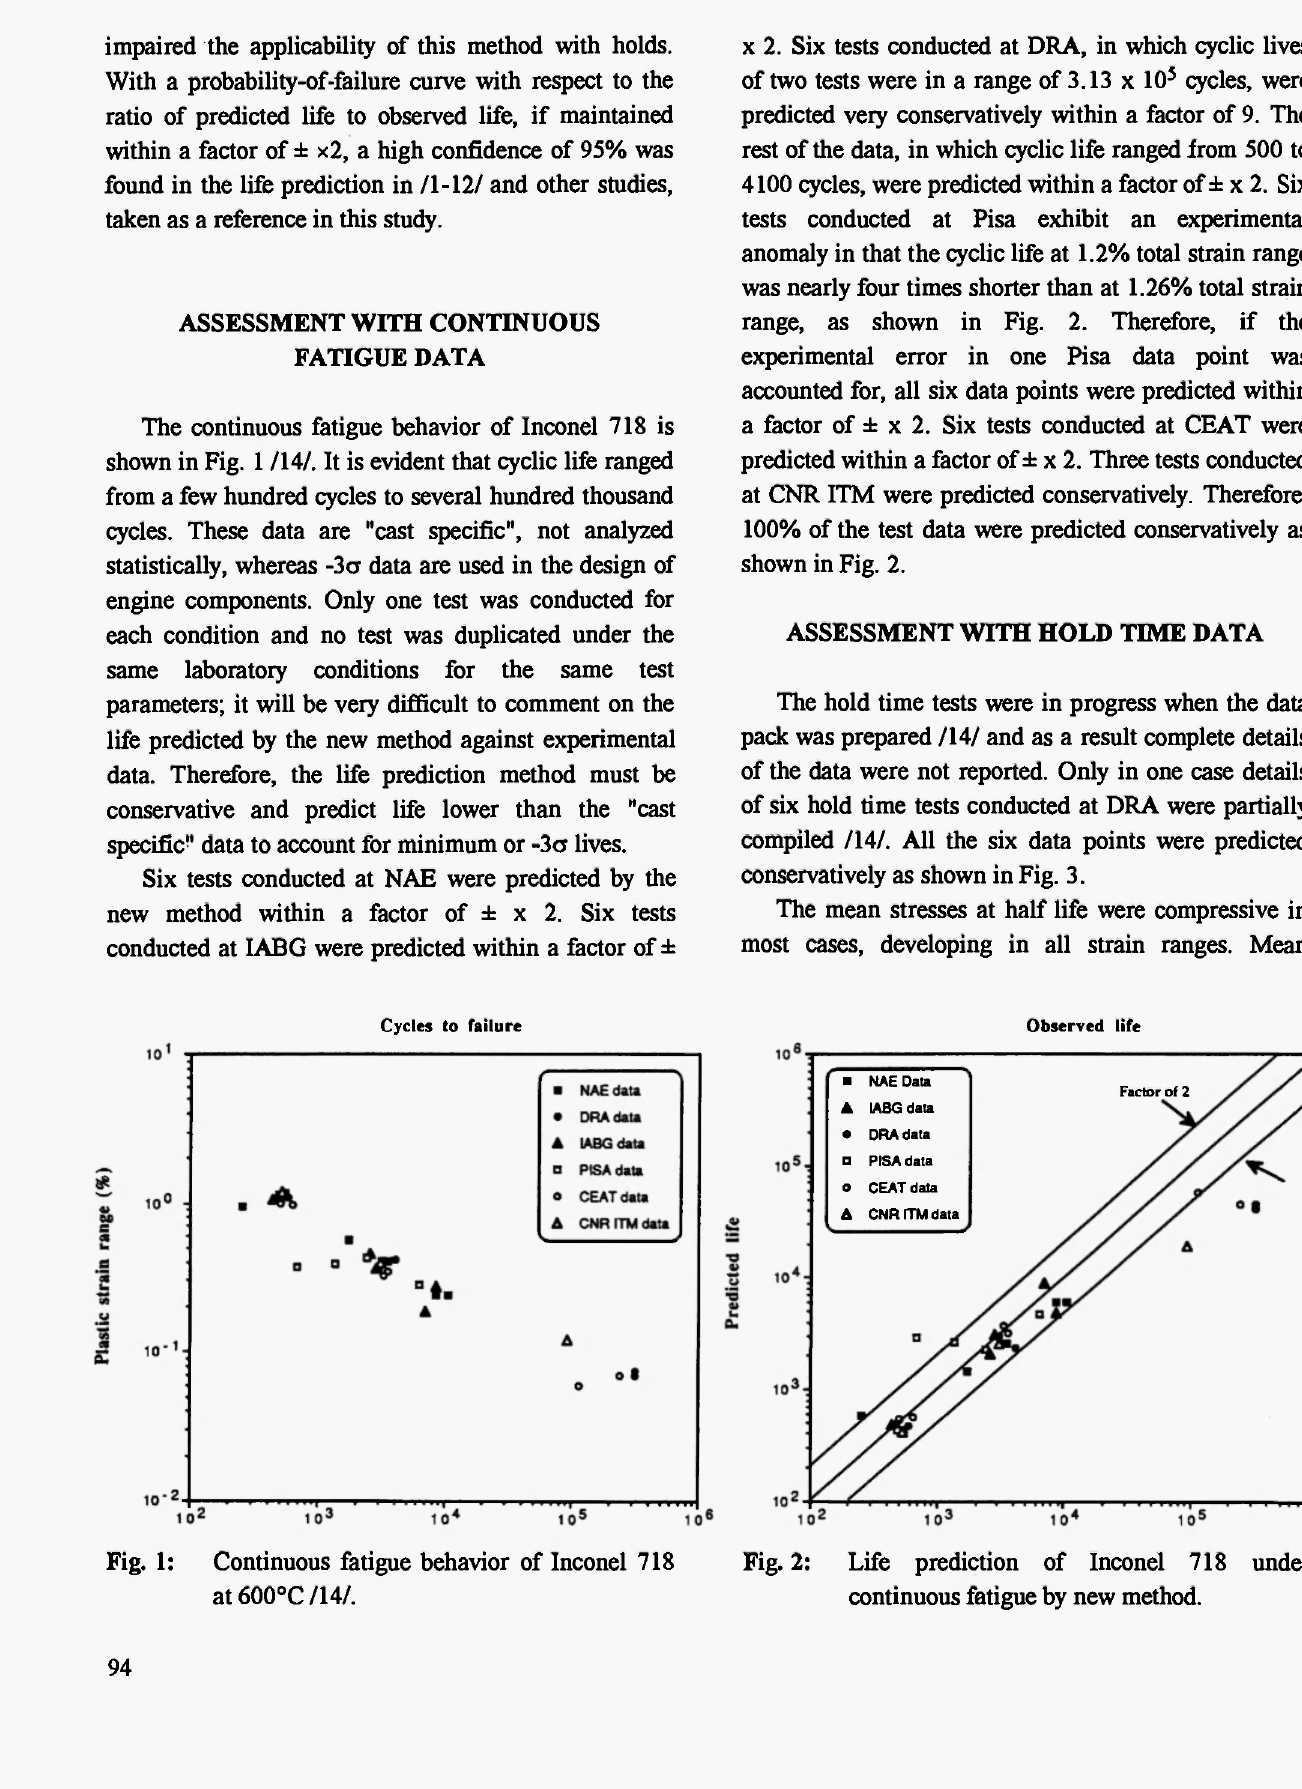
Fig. 2: Life prediction of Inconel 718 under continuous fatigue by new